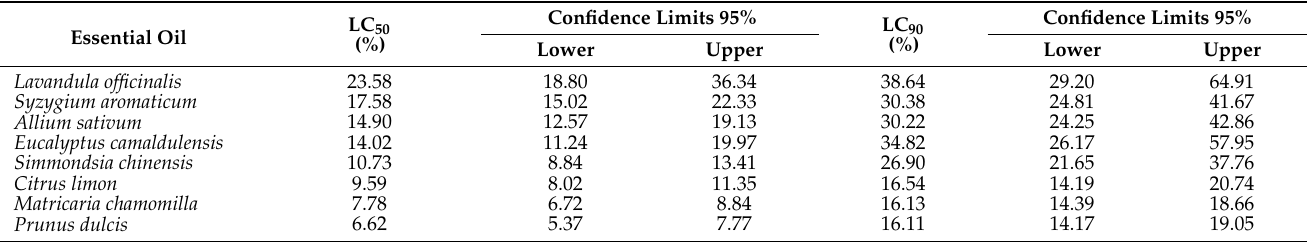
Table 3. The contact toxicity of the eight essential oils against the adult stage of T. castaneum after 24 h from exposure time.